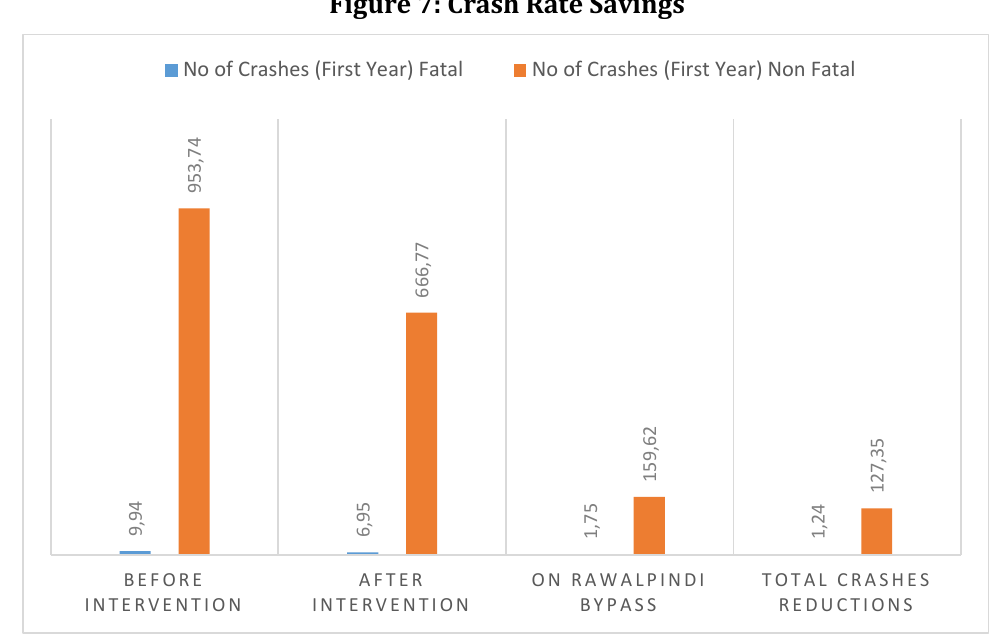
Figure 7: Crash Rate Savings